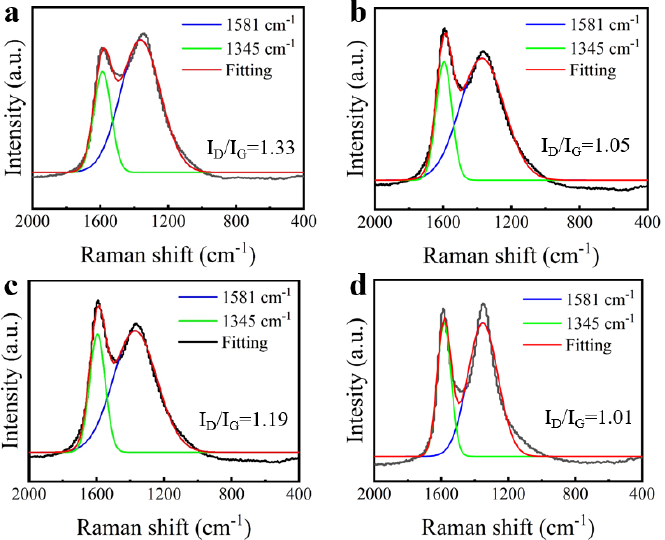
Figure 8. Raman spectra of char residues of ( a ) pure EP; ( b ) rGO/EP composite; ( c ) DOPO-M/EP